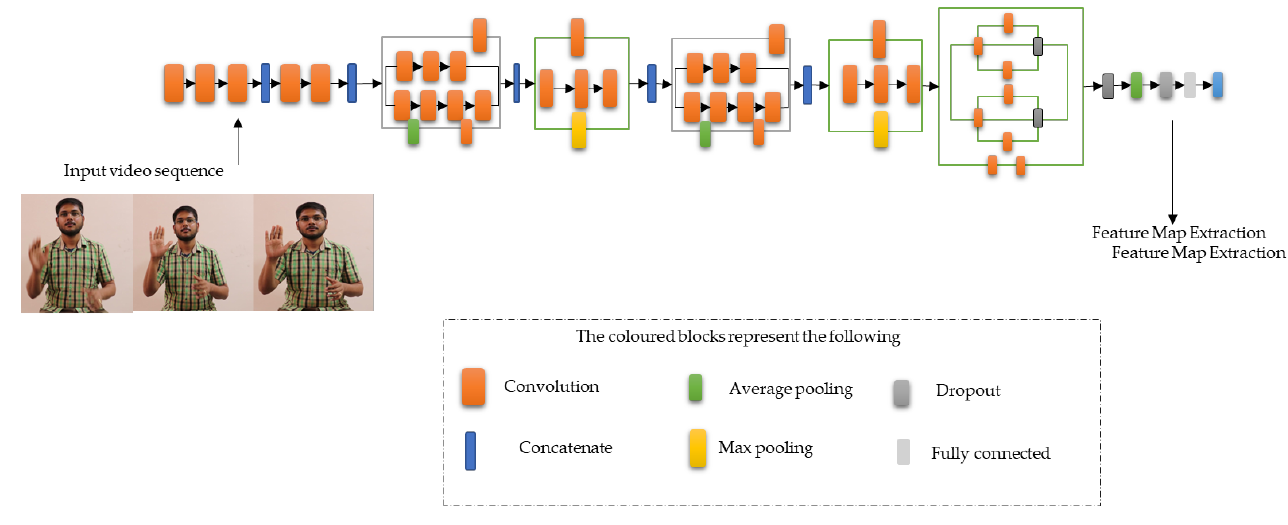
Figure 7. Inception V3 architecture extraction of features from each